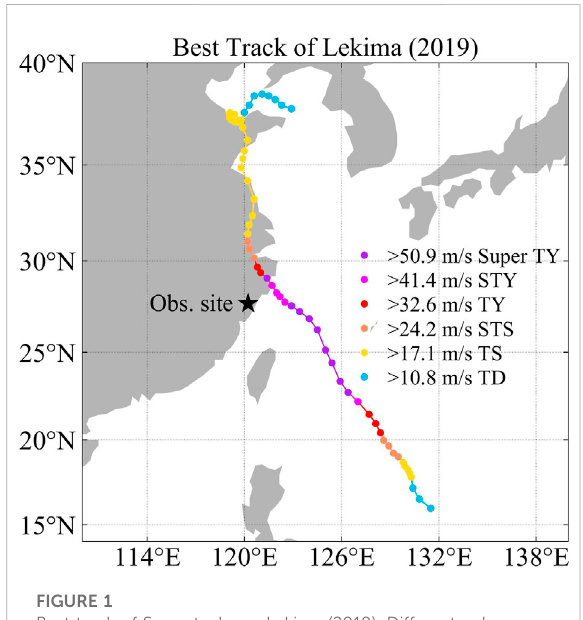
Best track of Super typhoon Lekima (2019). Different colors represent different intensities. Super TY: super typhoon, STY: severe typhoon, TY: typhoon, STS: severe tropical storm, TS: tropical storm, and TD: tropical depression. Black star indicates the location of the fi eld experiment.